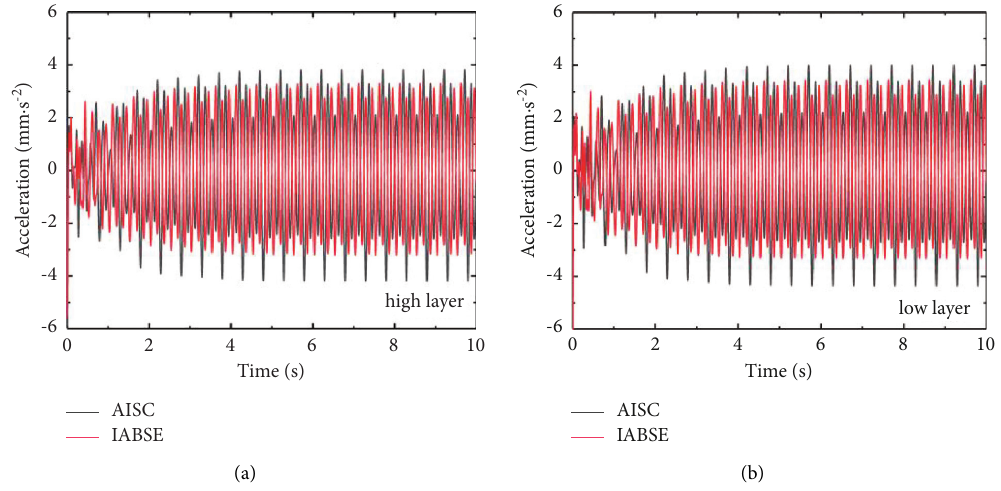
Figure 11: The acceleration response of global simplified FE model applied at point 1. Table 4: Loading position and maximum RMS acceleration of the